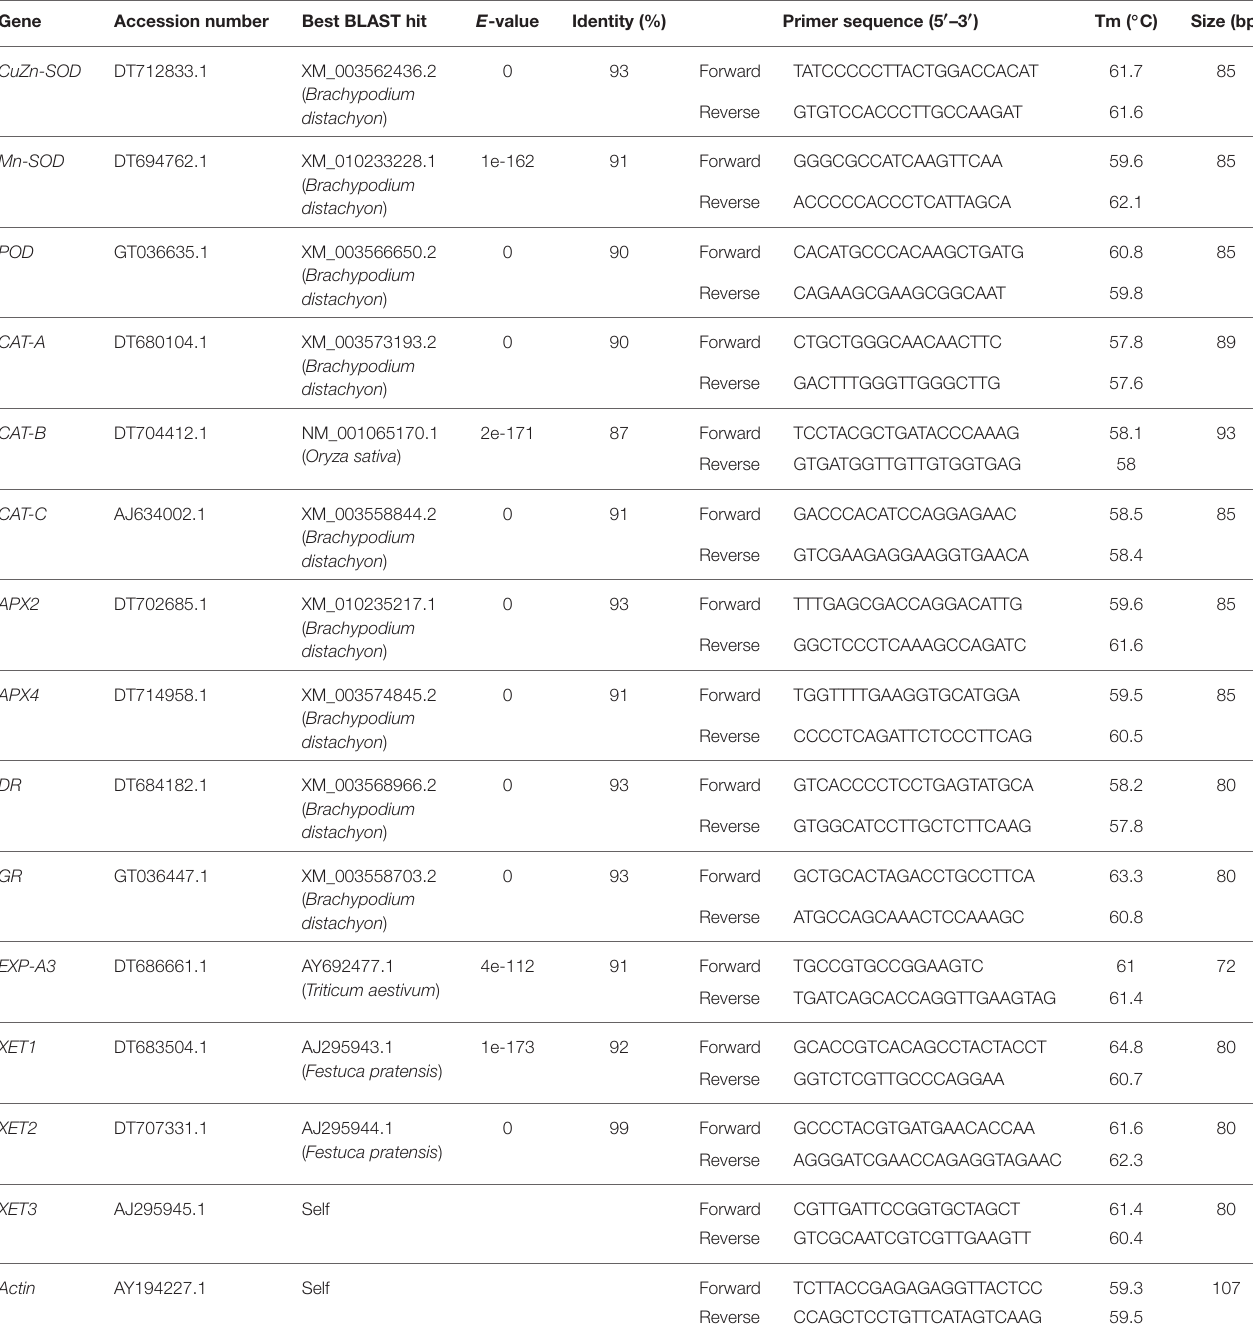
TABLE 1 | Primer sequences used in